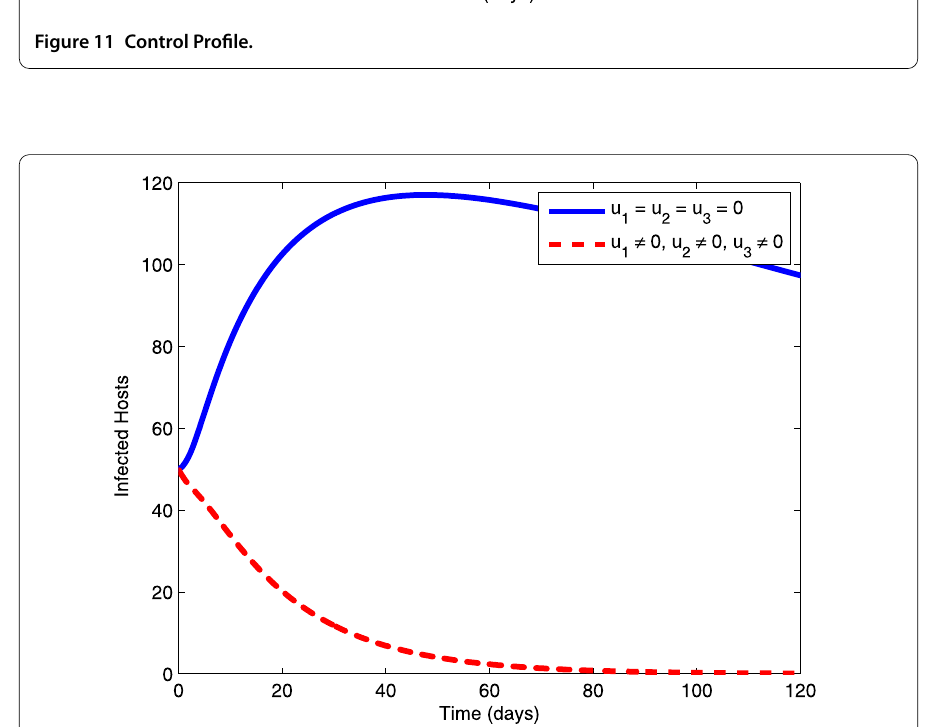
Figure 11 Control Profile.